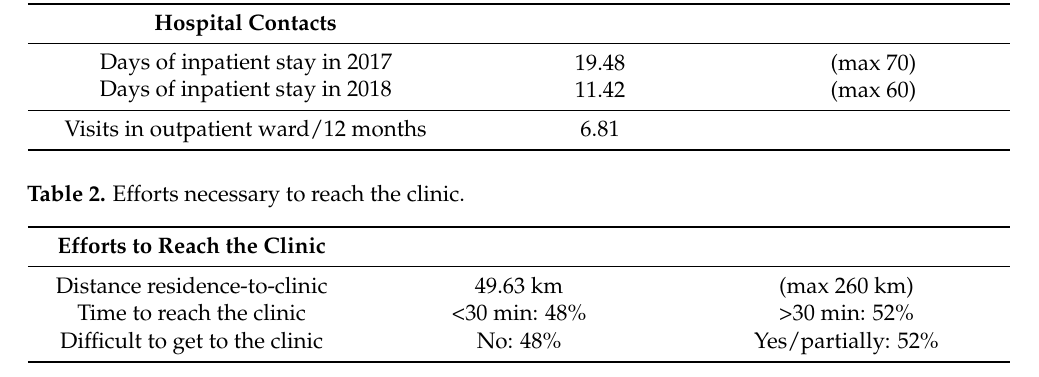
Table 1. Hospital contacts (average values).